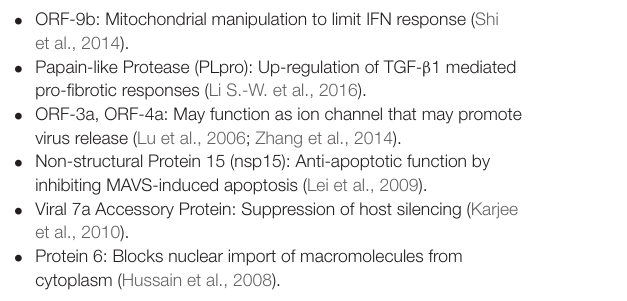
TABLE 2 | Other potential targets (from SARS-CoV) for silencing and their perceived